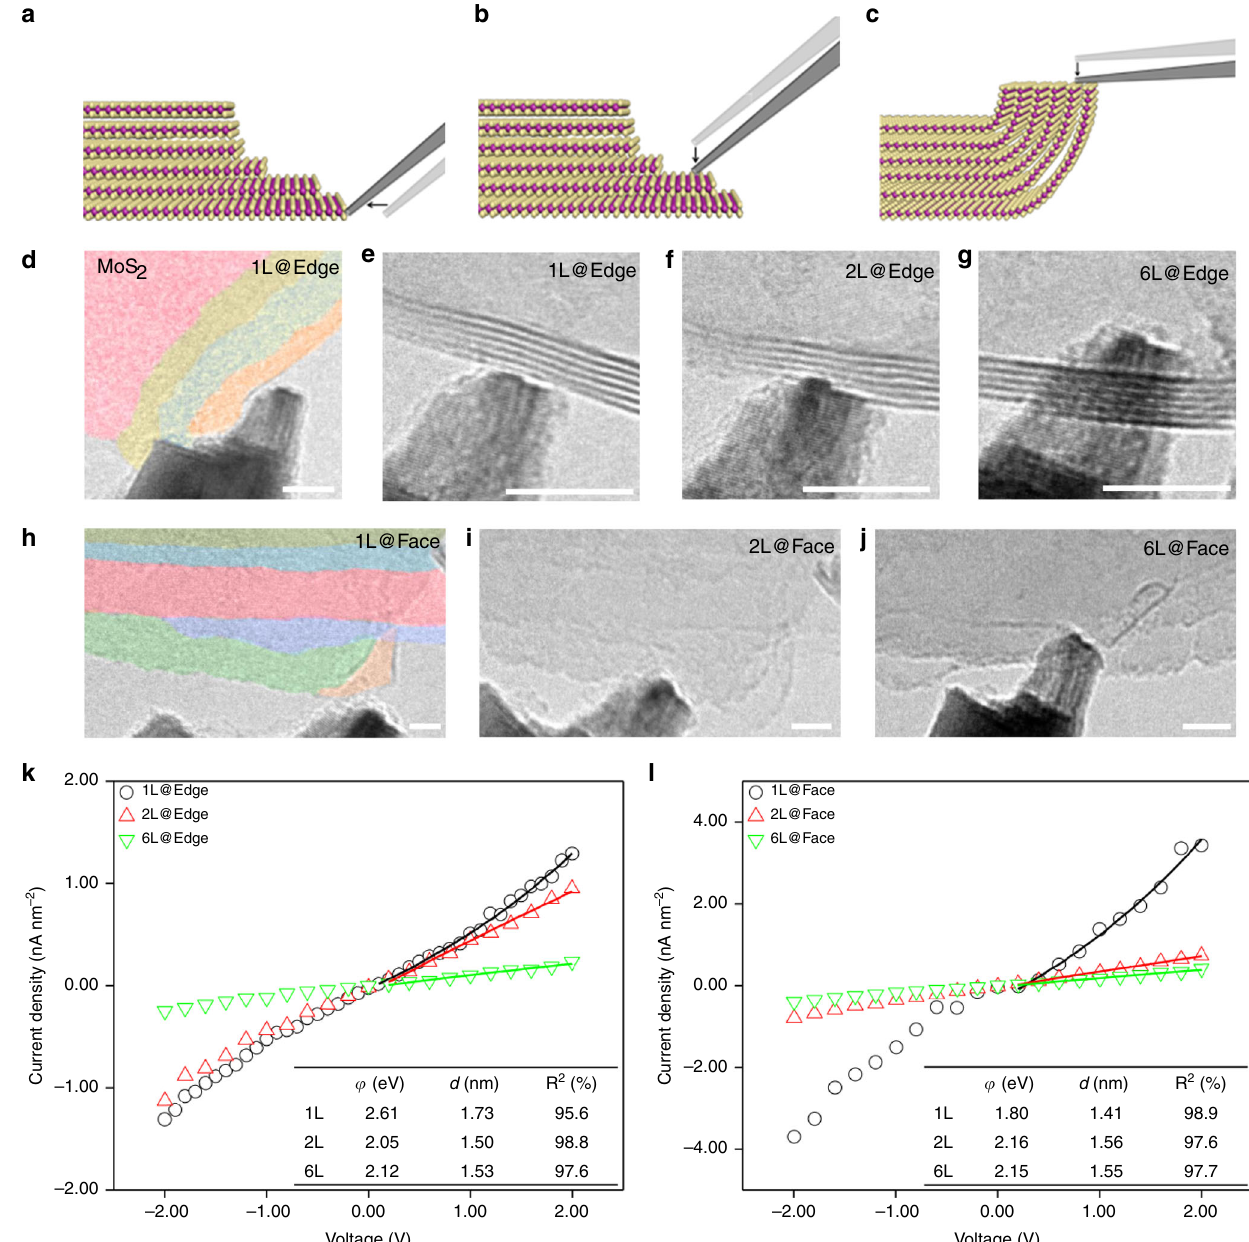
Fig. 2 Electrical contacts of W-exfoliated MoS 2 . Side view illustrations of a 1L MoS 2 edge contact, b 2L MoS 2 face contact, and c 2L MoS 2 edge contact. The yellow, purple, and white balls on a – c represent sulfur atoms, molybdenum atoms, and tungsten atoms, respectively. The black arrows in a – c indicating the moving direction of the W tip. TEM images of d , e 1L, f 2L, and g 6L edge contact. TEM images of h 1L, i 2L, and j 6L face contact. The color on d , h aims to enhance the contrast of the stair-like structure. Scale bars in d – j = 5 nm. k , l Current density – voltage ( J – V ) plots of e – g and h – j , respectively. The solid lines indicate the fi tted range. The inset table shows the fi tting parameters and the fi tting curves can be seen in Supplementary Fig.